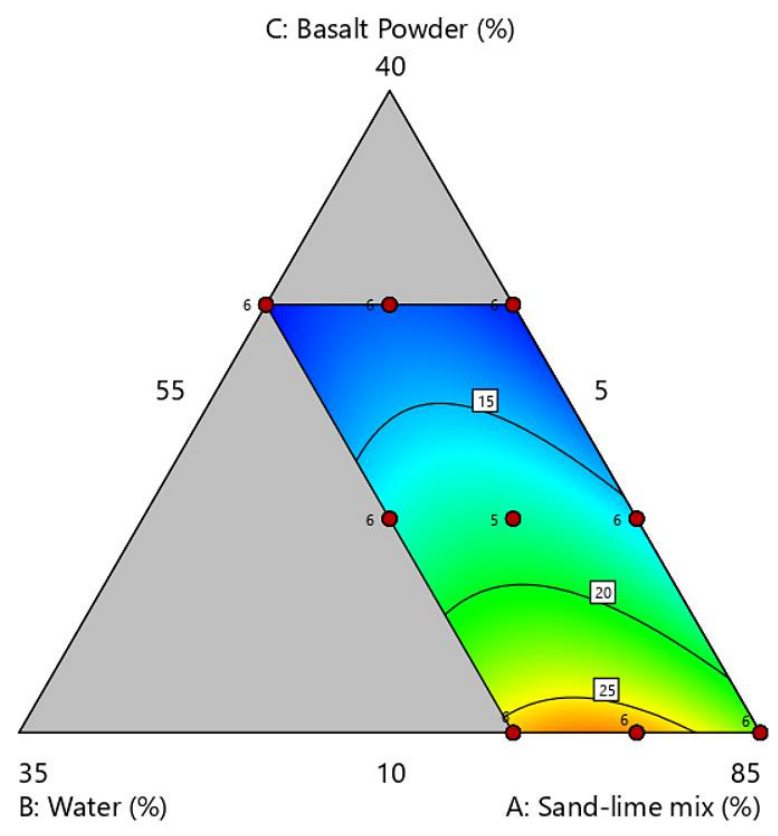
Figure 7. Ternary graph of compressive strength.